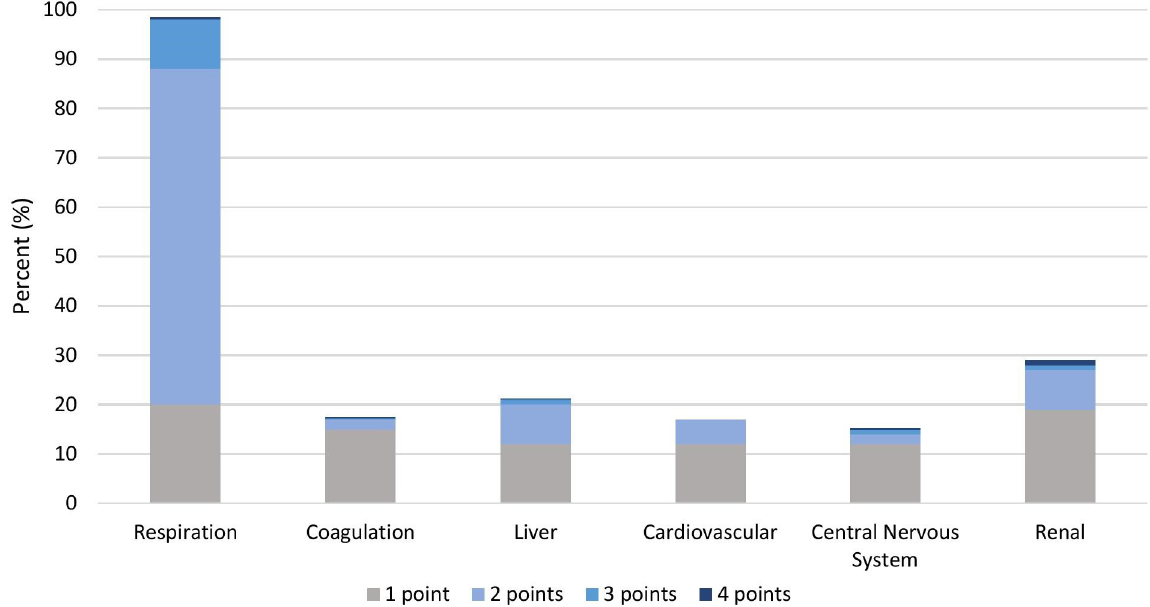
Fig 4. Distribution of points in the SOFA-score per organ system in 1,299 consecutive patients with Sepsis-3. The SOFA scores are corrected for the baseline levels.